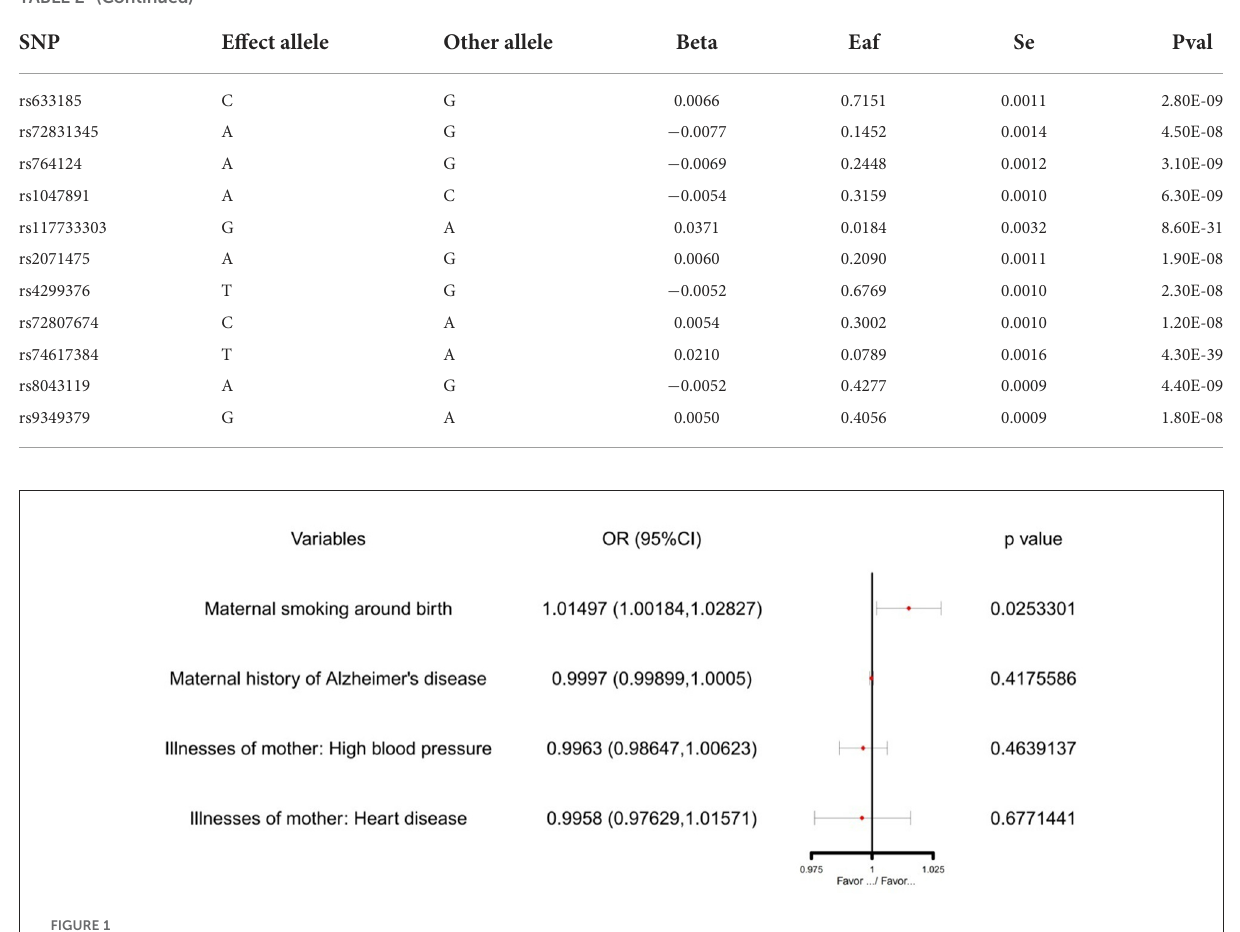
FIGURE1 The SVMR forest plot of maternal smoking around birth on childhood asthma susceptibility using SNPs.